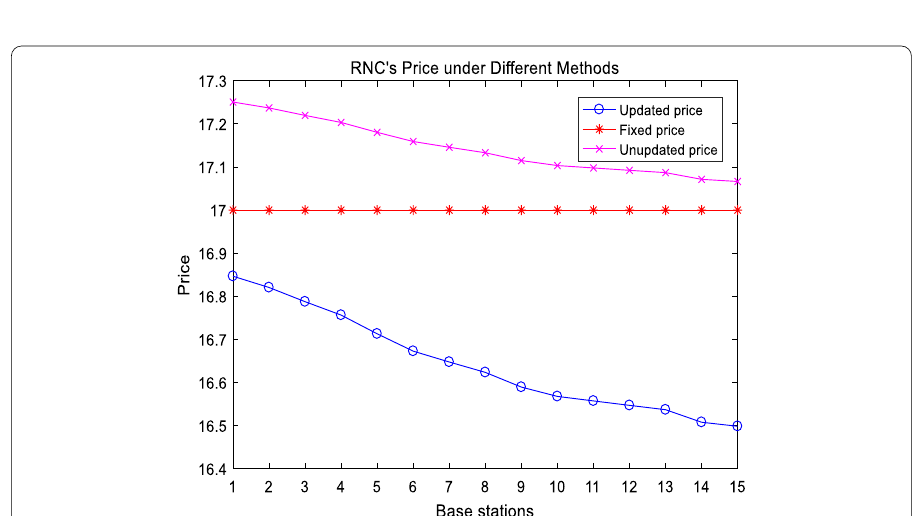
Fig. 4 RNC’s price for each base station. The blue curve represents the optimal price in the updated-price